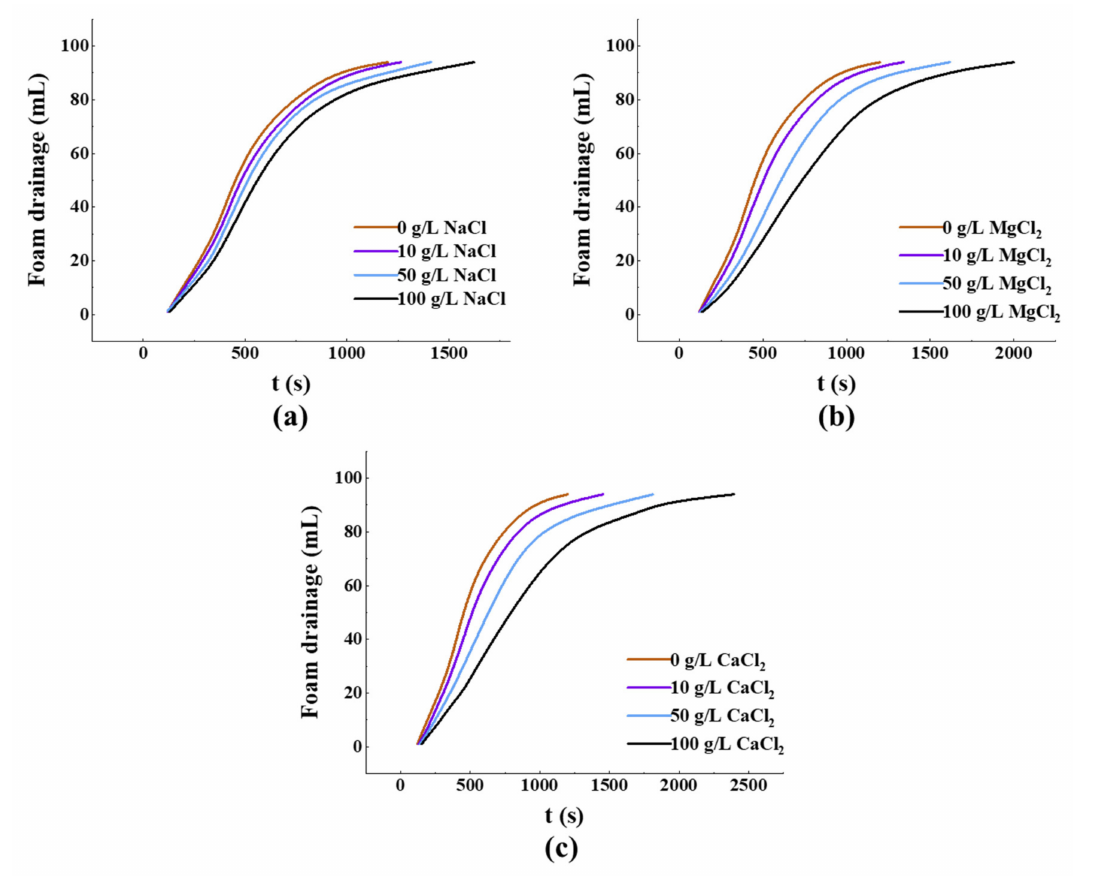
Figure 2. Drainage process of different foam systems. ( a ) NaCl, ( b ) MgCl 2 , and ( c ) CaCl 2